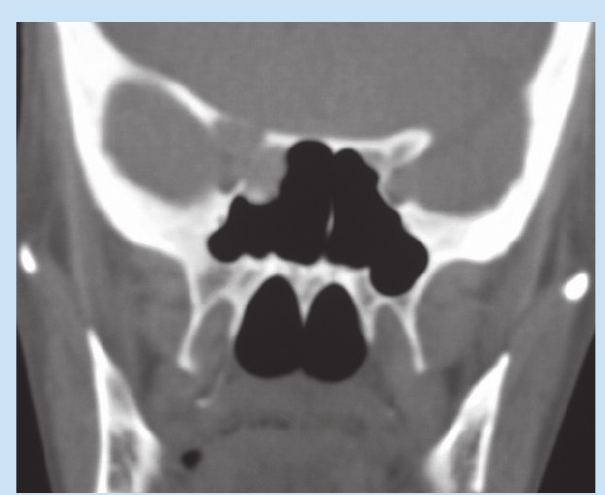
Fig. 2. CT shows expansile, lytic lesion of the right skull base and anterior clinoid